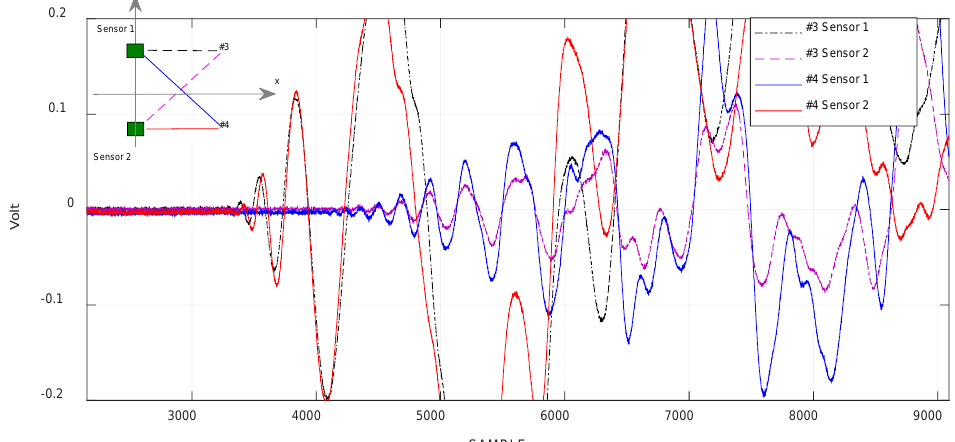
Figure 6. Acquired signals by sensor 1 and sensor 2, generated by an impact, respectively, in positions #3 and #4. Ts = 100 ns.